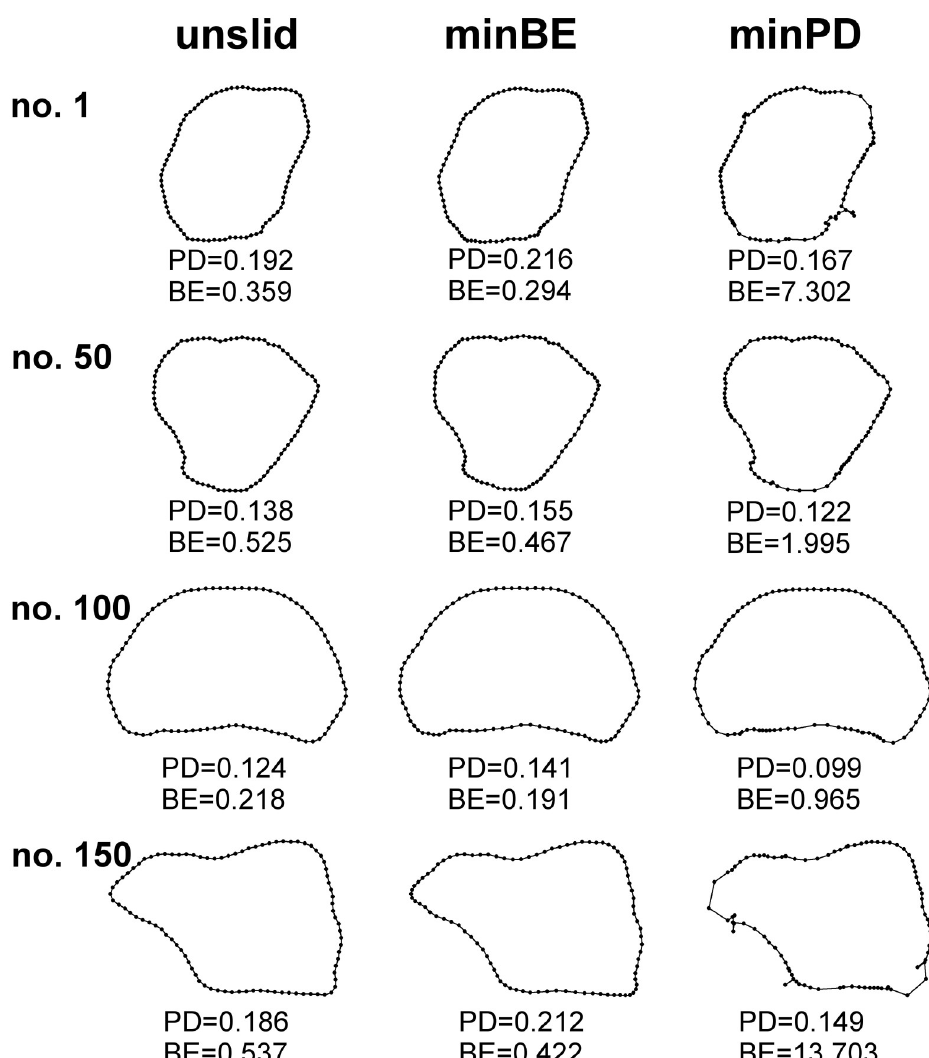
Fig 2. Outlines of four H . tuna segments from the overall dataset registered by the three parallel strategies of semilandmark treatment. Numbers refer to the order of segments in the studied dataset. unslid = equidistant semilandmarks without any additional sliding; minBE = minimum bending energy; minPD = minimum Procrustes distance. PD = Procrustes distance of the actual segment to the consensus configuration. BE = Thin-plate spline bending energy from the consensus configuration to the depicted